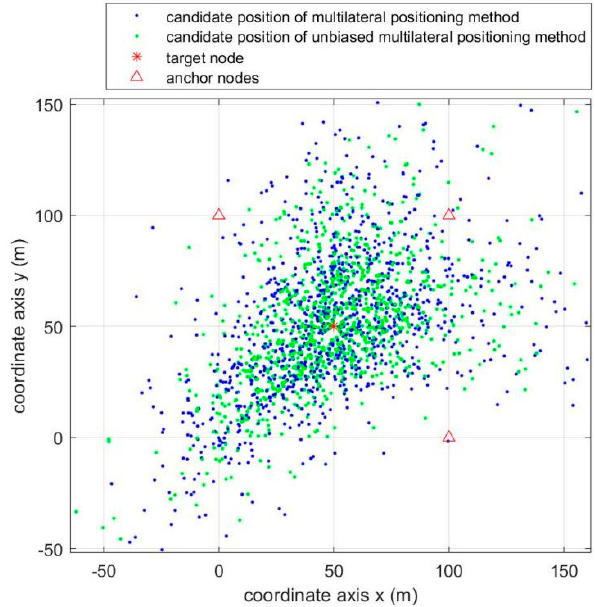
Figure 3. Two algorithm positioning scatter plots.